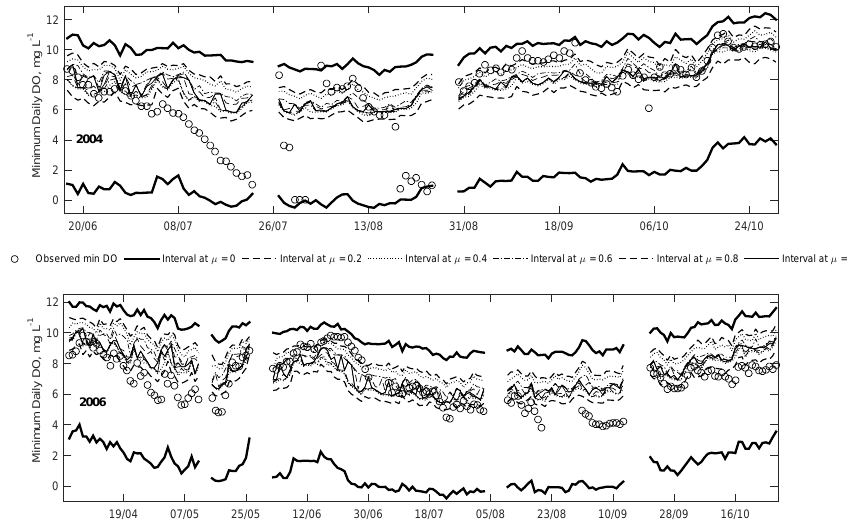
Figure 7. A comparison of the observed and predicted minimum DO trends for 2004 (top panel) and 2006 (bottom panel).